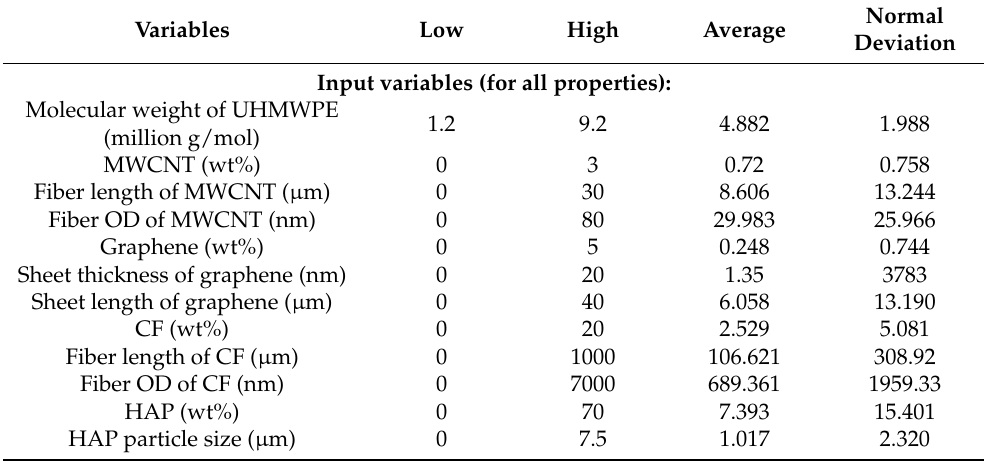
Table 1. Higher and lower values of every input and output parameter, with its normal deviation and